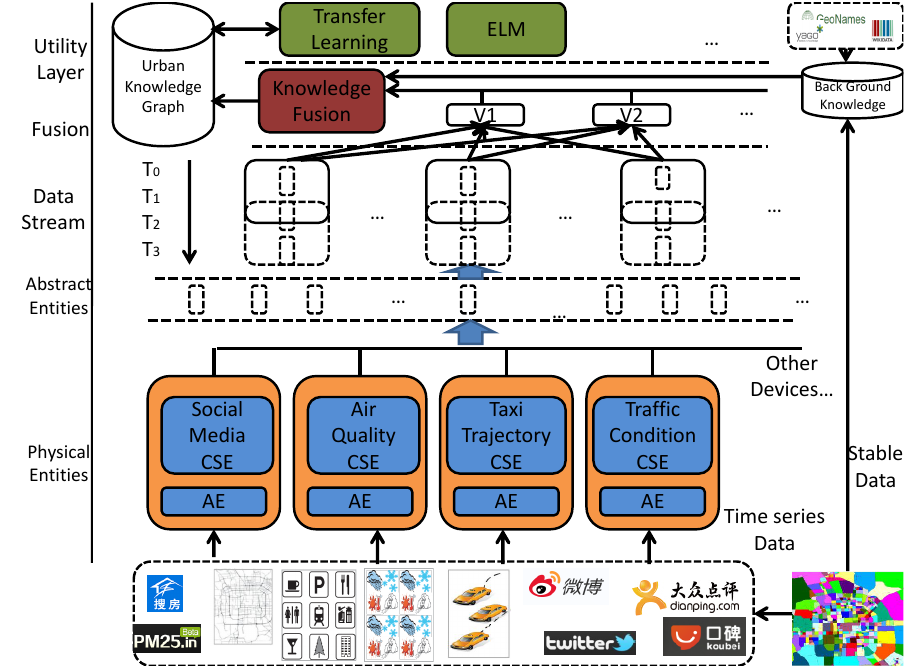
Figure 1. Semantic framework of IoT integrated with machine learning for smart city